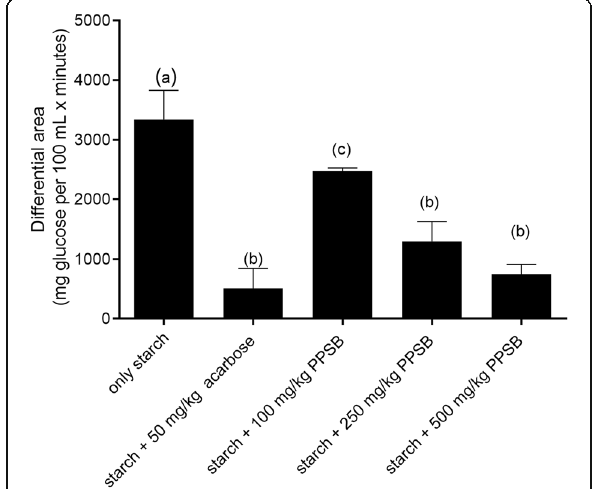
Fig. 3 Areas between the glycemic curves after starch administration (starch alone or starch plus α -amylase inhibitors) and the glycemic basal levels. The areas were determined with the corresponding data in Fig. 2 using the numerical integration procedures of the Graph Pad version 5.0. The error terms correspond to standard deviation of the means. Letters indicate statistical difference relative to the situation in which starch alone was administered according to ANOVA followed by post hoc testing according to Tukey ( p ≤